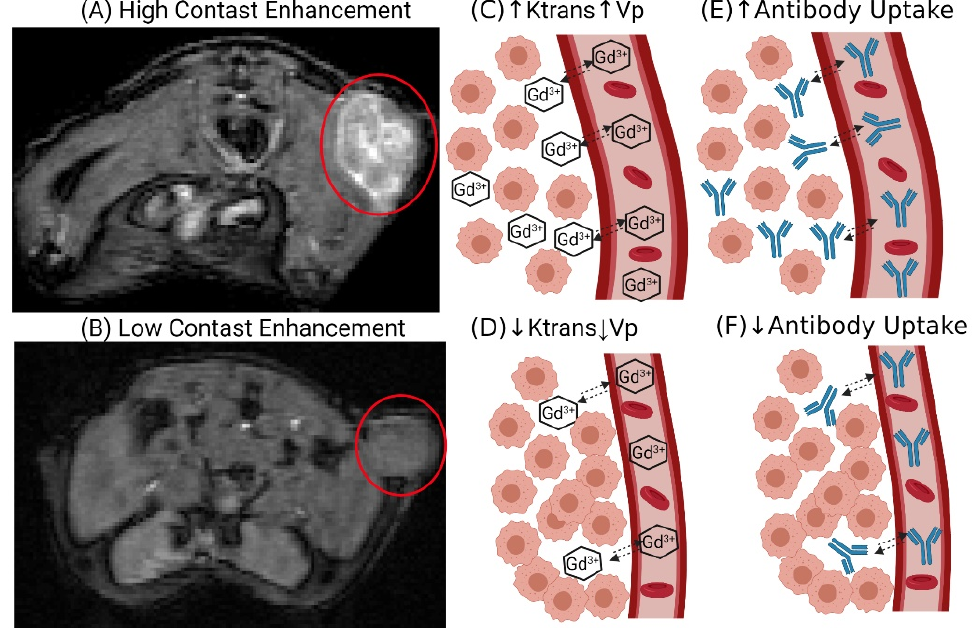
Figure 1. DCE-MRI: The DCE-MR images on the left side provide examples of a tumor with high contrast enhancement ( A ) and low contrast enhancement ( B ) following gadobutrol injection. High contrast enhancement is the result of greater gadobutrol uptake into the tumor ( C ), which results in larger values for Ktrans and Vp relative to the low contrast-enhancing tumor ( D ). The DCE-MRI parameters are representative of tumor physiology (vascular permeability, plasma volume, and blood flow) that is known to impact mAb disposition; therefore, the high contrast-enhancing tumor is expected to have greater mAb uptake ( E ) relative to the low contrast-enhancing tumor ( F ). Created with BioRender.com (accessed on 23 Novermber